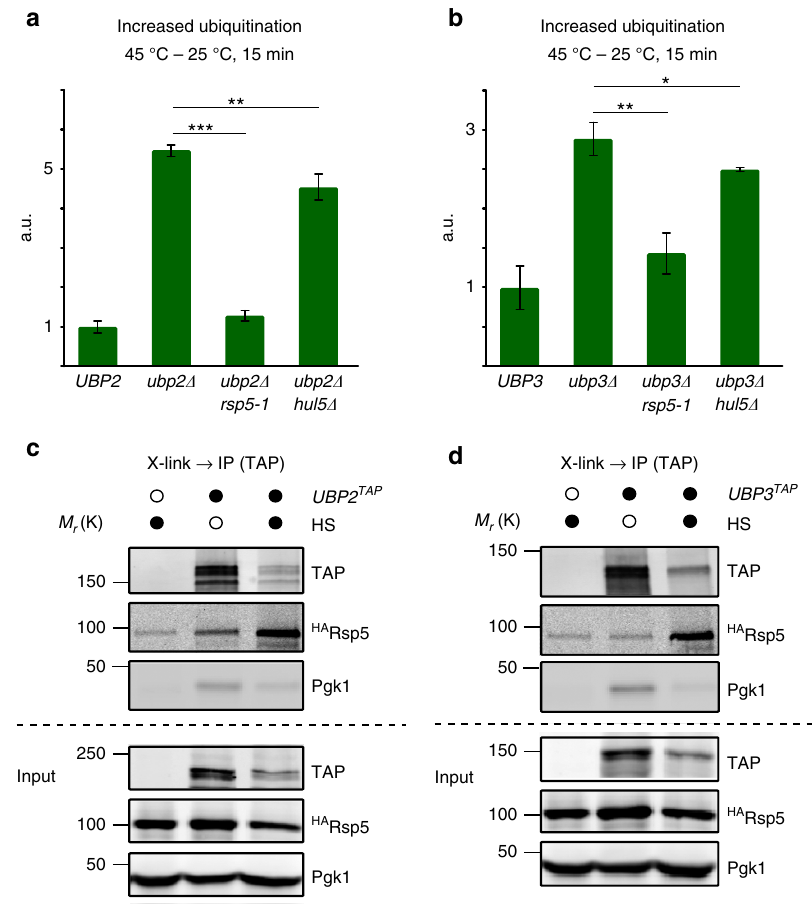
Figure 2 | Ubp2 and 3 mainly deubiquitinate Rsp5 substrates and have increased interactions with Rsp5 after HS. ( a , b ) Increased ubiquitination levels after a 15min HS at 45 (cid:2) C in the indicated cells quantified by dot-blot and compared with unstressed cells (25 (cid:2) C). Experiments were done with three biological replicates and averaged values are shown with s.d. In each experiment, increased ubiquitination levels were compared, as shown, to the deletion or WT strains using a two-tail student t -test (*** P o 0.001; ** P o 0.01; * P o 0.05). a.u., arbitrary units. ( c , d ) Cells expressed 3xHA-tagged Rsp5 from a plasmid and endogenously C-terminally TAP-tagged UBP2 or UBP3, when indicated (black circles). Before lysis, cells that remained at 25 (cid:2) C (unfilled circles) or heat shocked (40 (cid:2) C, 20min; black circles) were crosslinked for the remaining 10min with 1% formaldehyde. Western blots of the indicated proteins are